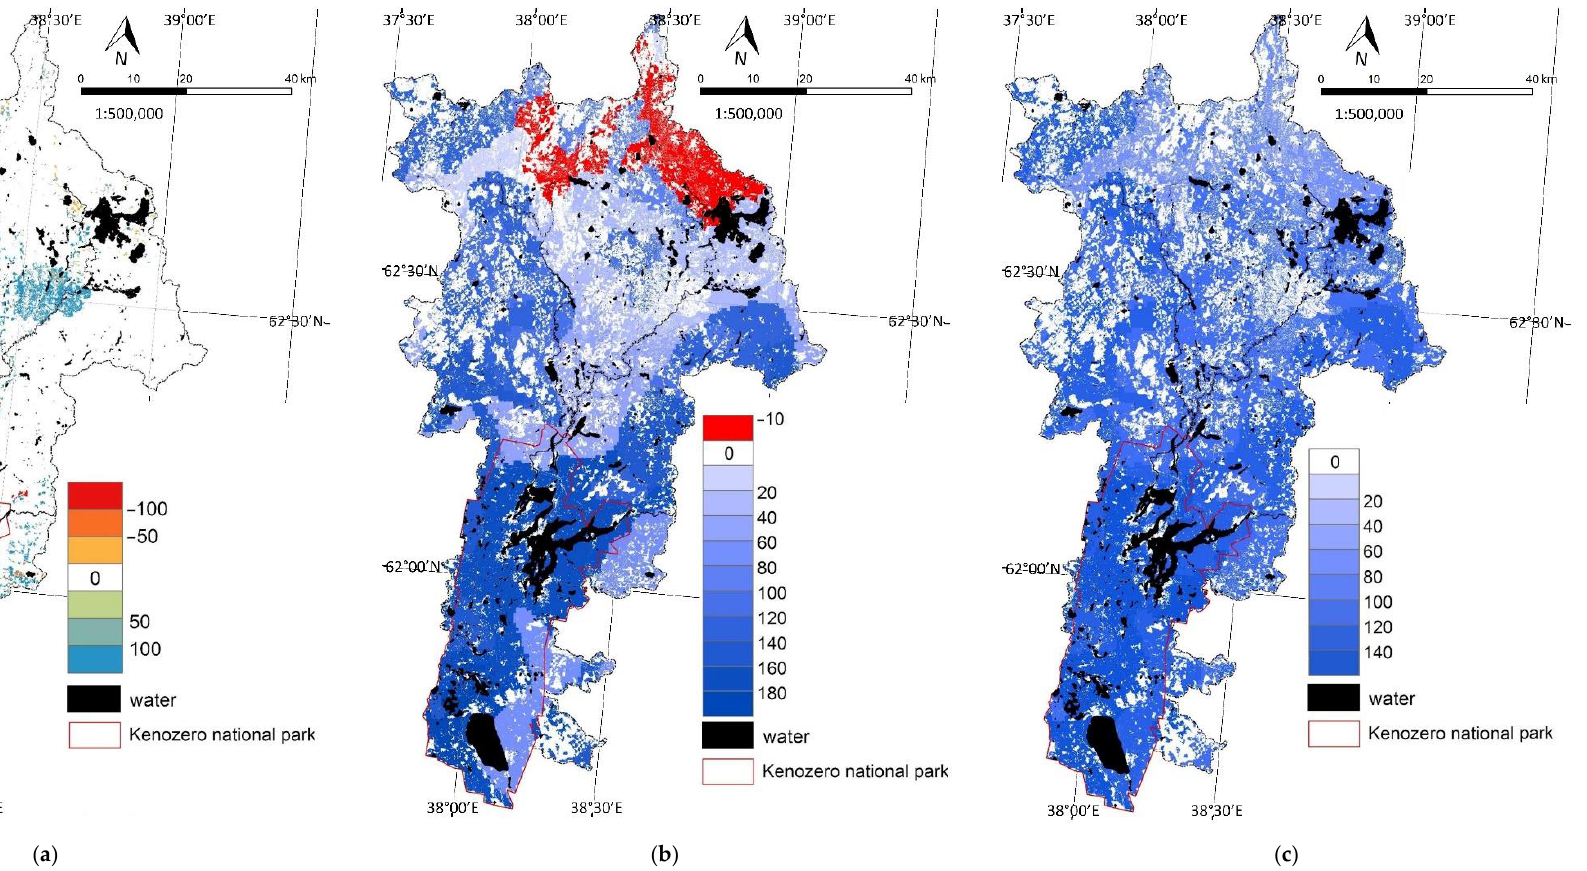
Figure 5. Runoff changes due to forest felling: ( a ) changes in runoff between 2007 and 2021 (mm/year); ( b ) changes after hypothetical case of total forest felling, compared to 2021 (mm/year); ( c ) changes in runoff 3 years after total forest felling, compared to 2021 (mm/year).